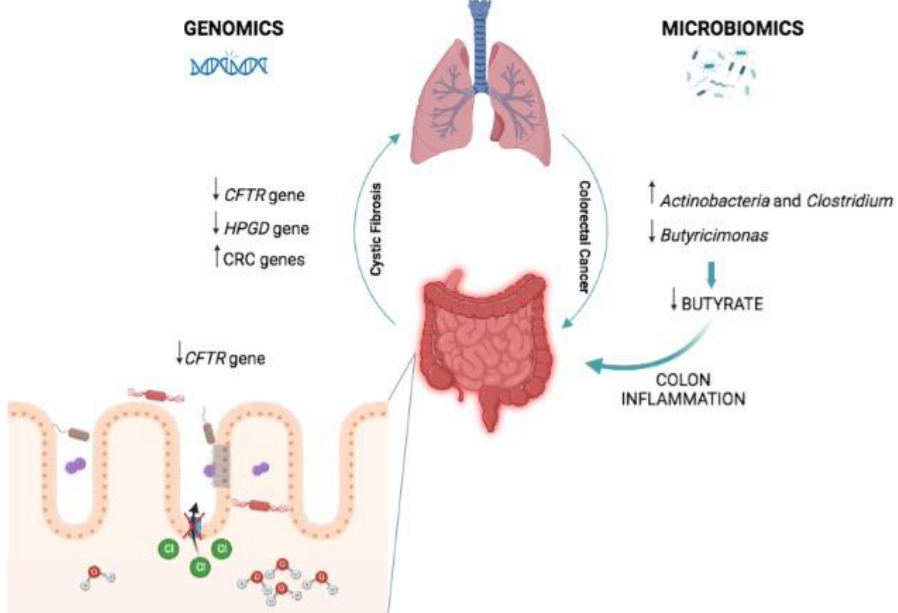
Figure 3. Prevalence in the microbiota of Actinobacteria and Clostridia and reduced level of butyrate- producing bacteria, along with downregulation of the host CFTR gene and HPGD genes predisposed to CF, which may lead to